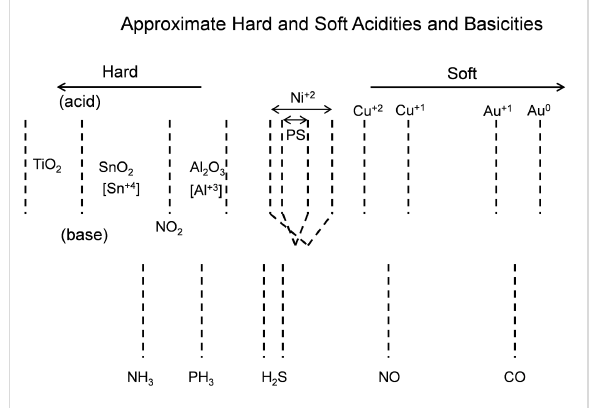
Figure 2: Estimated hard and soft acidities and basicities based on resistance changes relative to a p-type and n-type porous silicon inter-